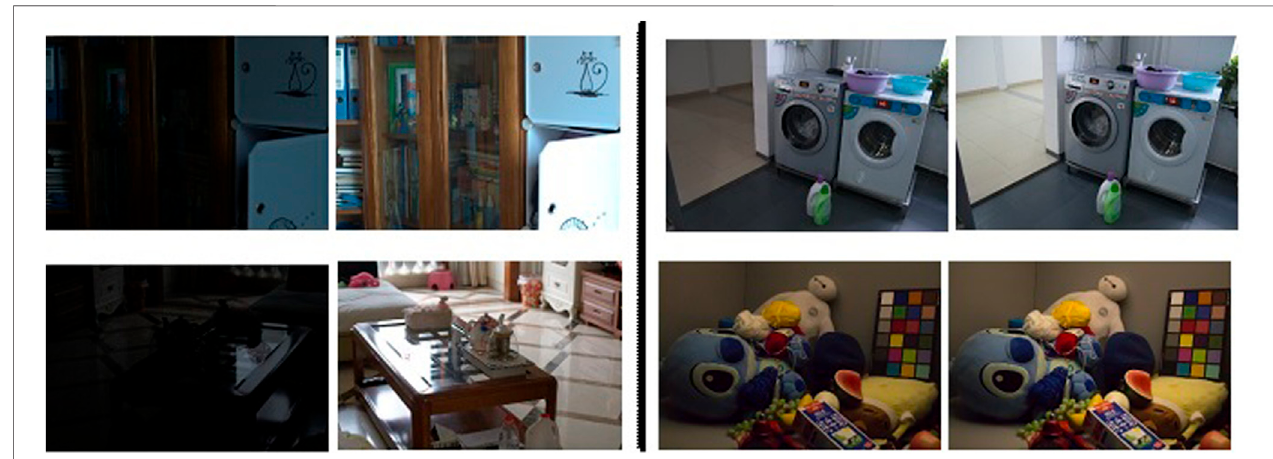
FIGURE 4 | Samples of training data pairs showing low light image samples (left) and normal light image samples (right) .